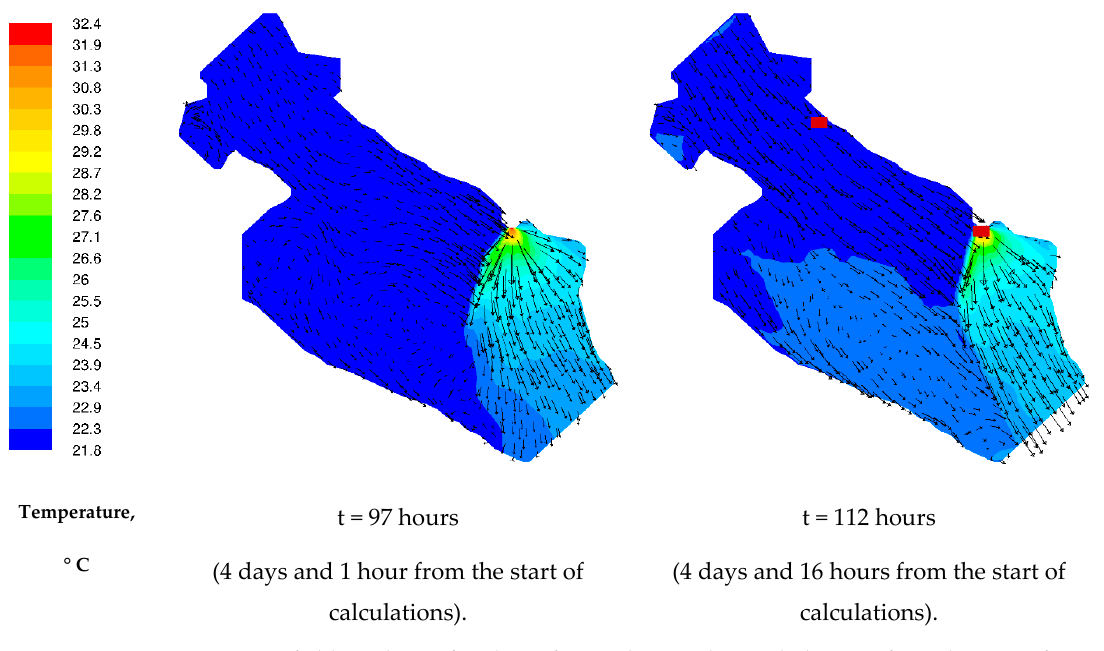
Figure 10. Temperature fields in the surface layer for northwesterly wind; the time from the start of calculations (t). The calculations were carried out for the period starting from midnight.